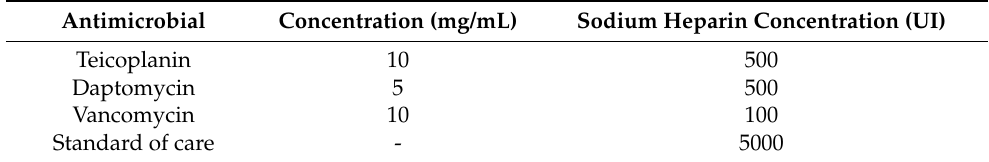
Table 1. Composition of the lock solutions used in the study.